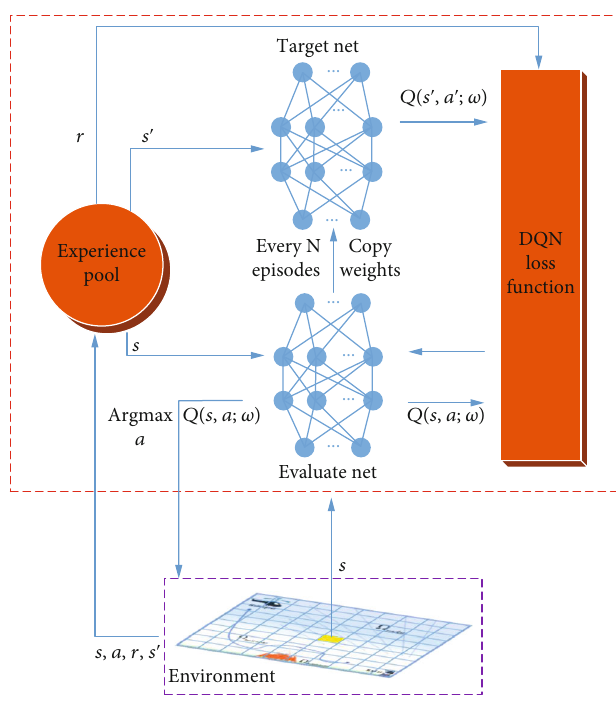
Figure 4: H-DQN algorithm